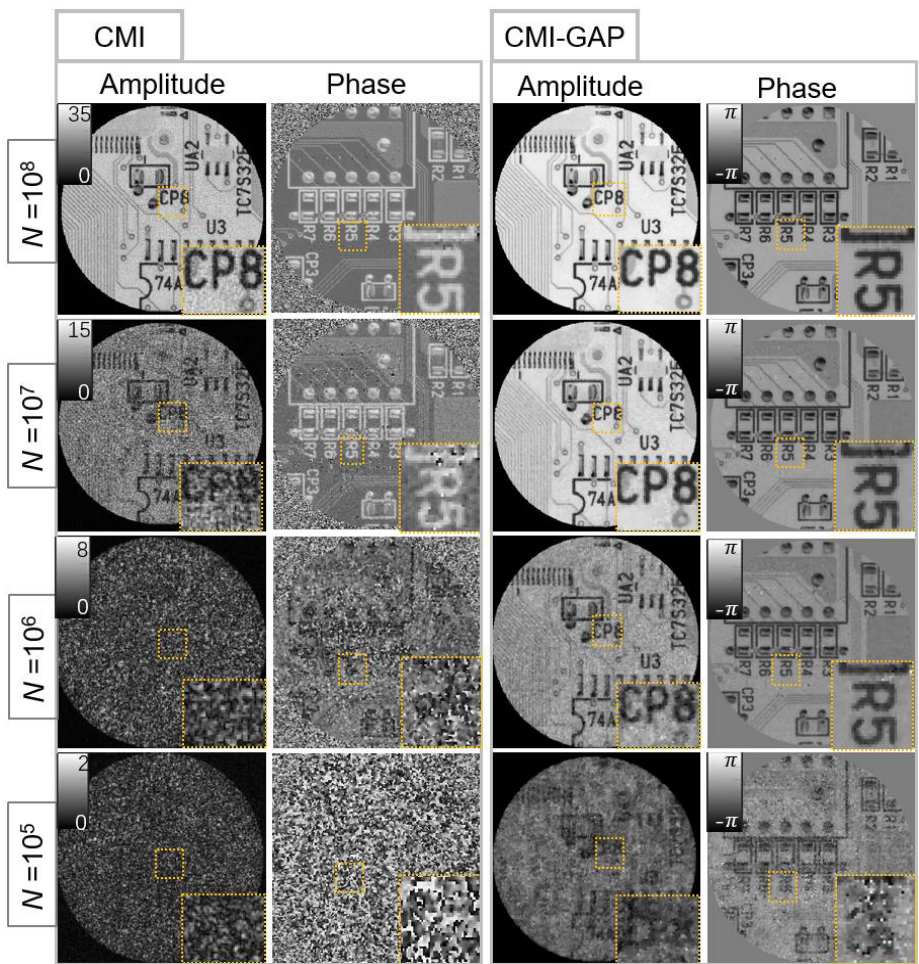
Figure 5. Reconstruction of the sample given far-field CMI simulated data at varying photon flux. In the lower right corner of each image is a larger version of the middle region. CMI-GAP produces significant enhancement on reconstruction quality.